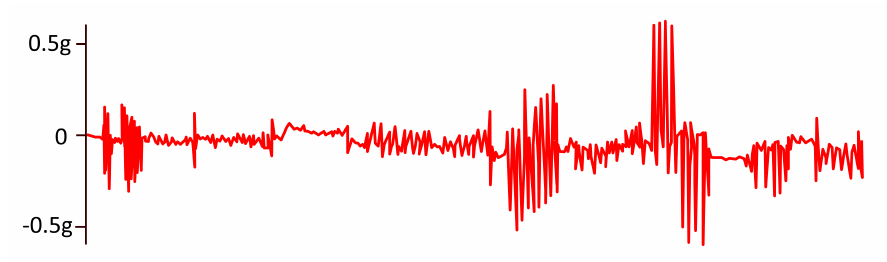
Figure 6. Example of uniaxial acceleration acquired with a physical activity monitoring